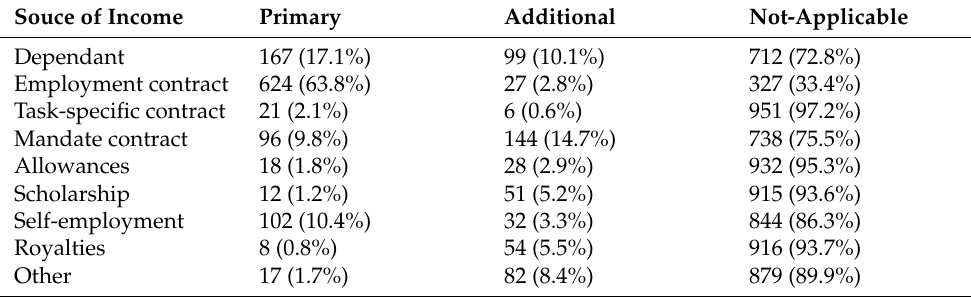
Table 2. Respondents’ sources of